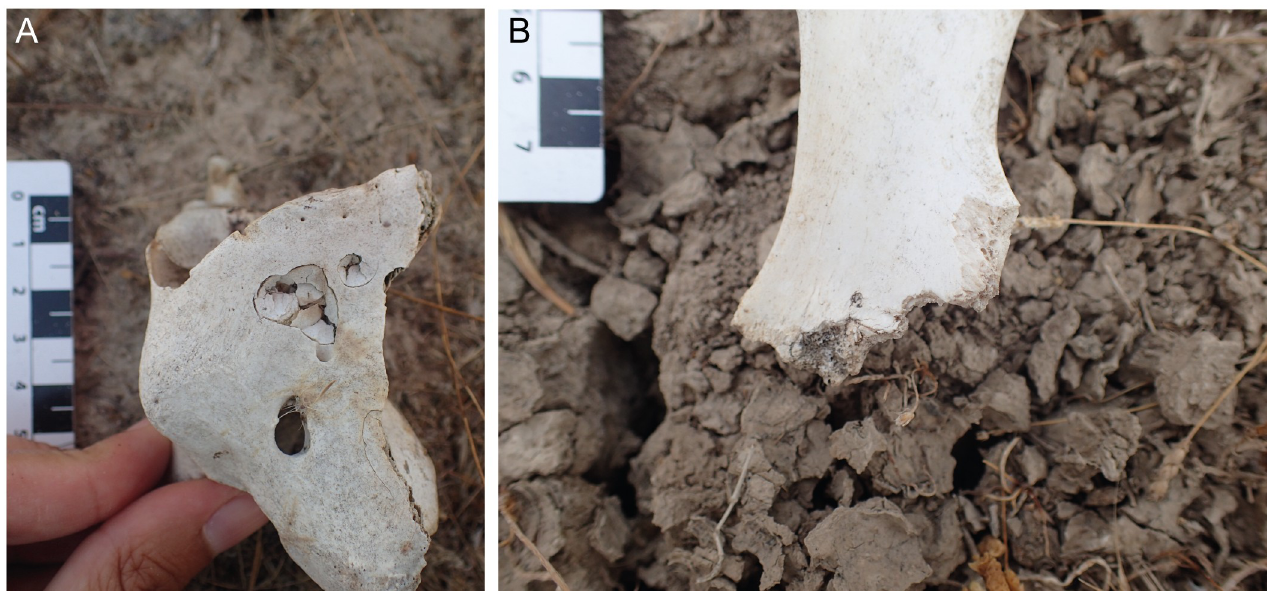
Fig 5. Chewing marks on DNP bones. (A) Red-deer atlas showing large punctures. (B) Close-up view of a wild-boar ischium showing furrows and a small